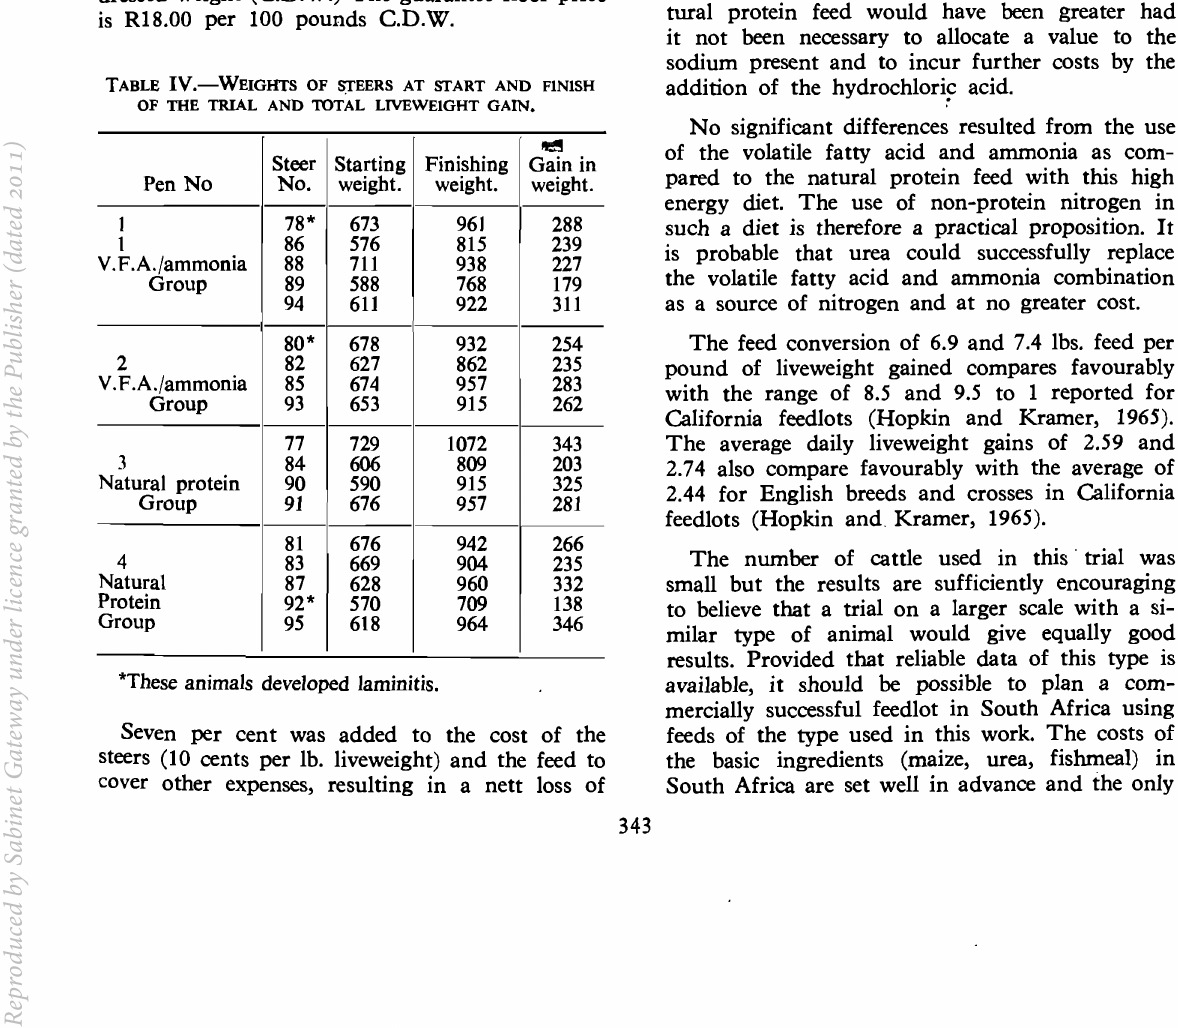
TABLE IV.-WEIGHTS OF s:rEERS AT START AND FINISH OF THE TRIAL AND 10TAL LIVEWEIGHT GAIN. iI'l!!I Steer Starting Finishing Gain in Pen No No.